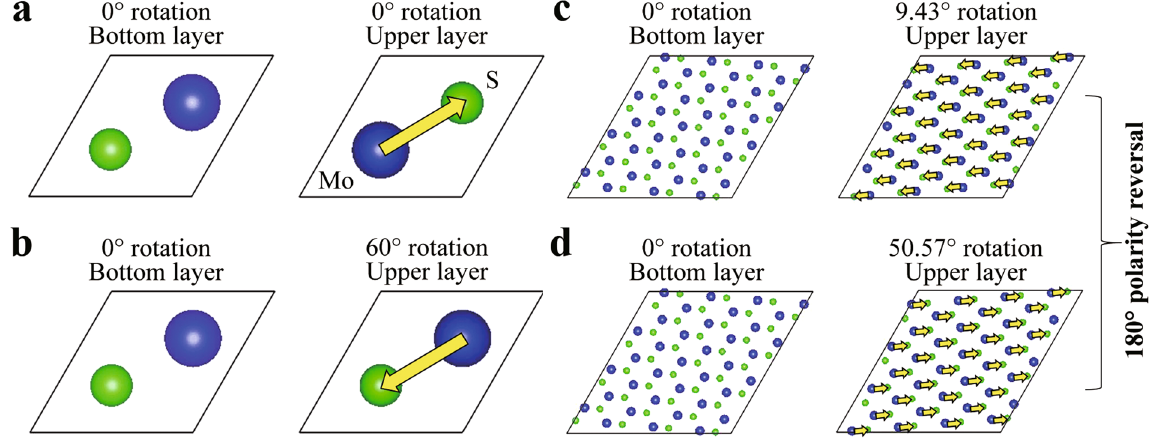
Figure 6. Symmetry between each pair of unit cells with RSFs of the x and 60° − x rotational angles. ( a , b ) Top views of the bottom and upper layers of the AB- and AA-stacked unit cells, whose rotational angles are 0° and 60°, respectively. The yellow arrows highlight the polarity change between the positions of the Mo and S atoms. See more details for the atomic structure of the AA-stacked unit cell in Supplementary Fig. S5. ( c , d ) Top views of the bottom and upper layers of the unit cells with RSFs of 9.43° and